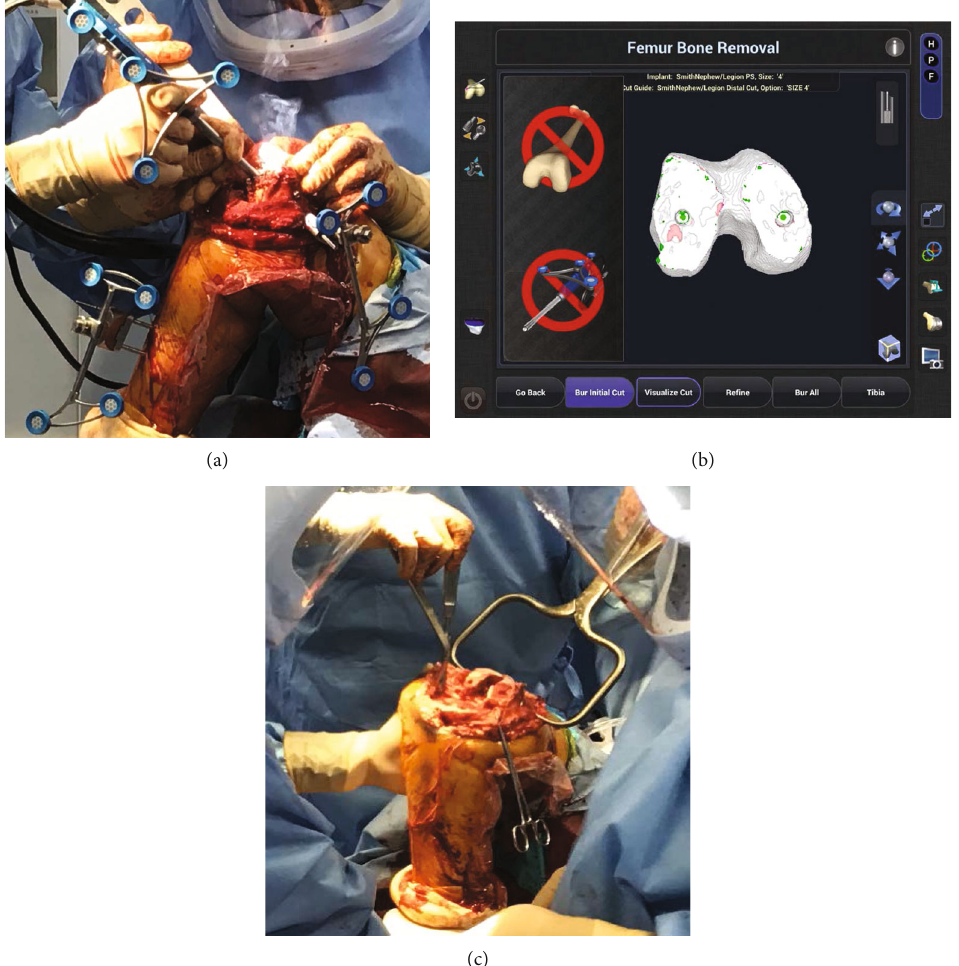
Figure 5: (a) Intraoperative photograph. (b) Navio screen allowing the surgeon to continually assess the patient anatomy against the plan. The articular cartilage and bone being removed using a hand-held sculptor. Green: approximately 1 mm or more and less than from target surface; white: near the target surface (less than 1mm); red: below the target surface. (c) After immobilizing the fracture site with a bone grasper before removing the pin tracker, reaming of the femur and insertion of a stem prosthesis were